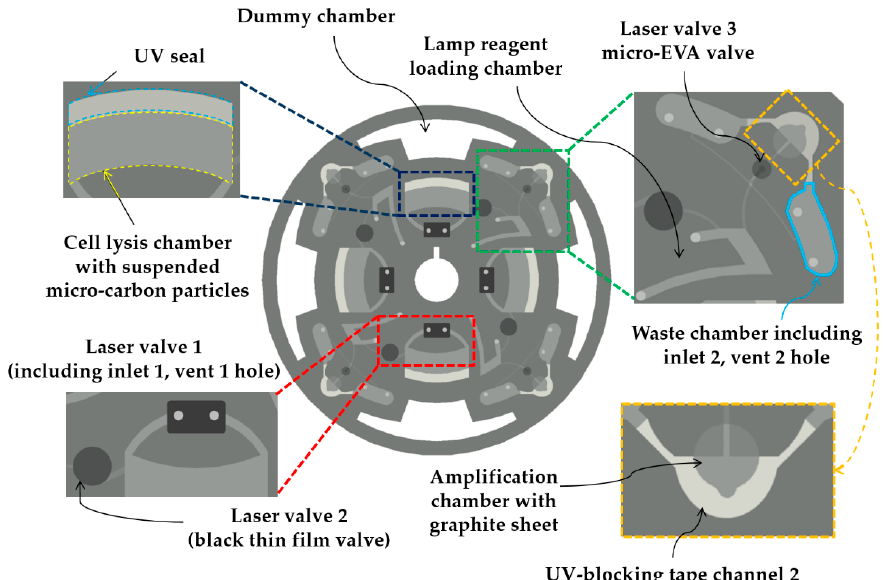
Figure 3. Disc fabrication top-view assembly using the Creo 4.0 Computer-Aided Design program. The disc was fabricated via axial patterning at a 90° angle to allow DNA detection four times on one disc. Differences from other designs are indicated by a dotted line or rectangle, and the name of each component is shown. Insets present detailed explanations where necessary.